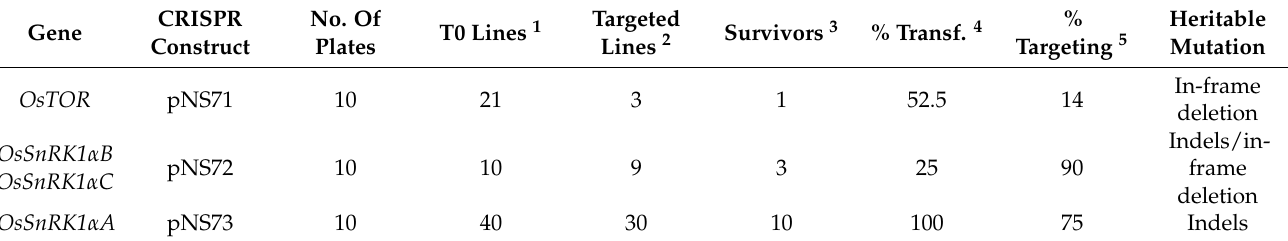
Table 1. Summary of targeting OsTOR and OsSnRK1 α